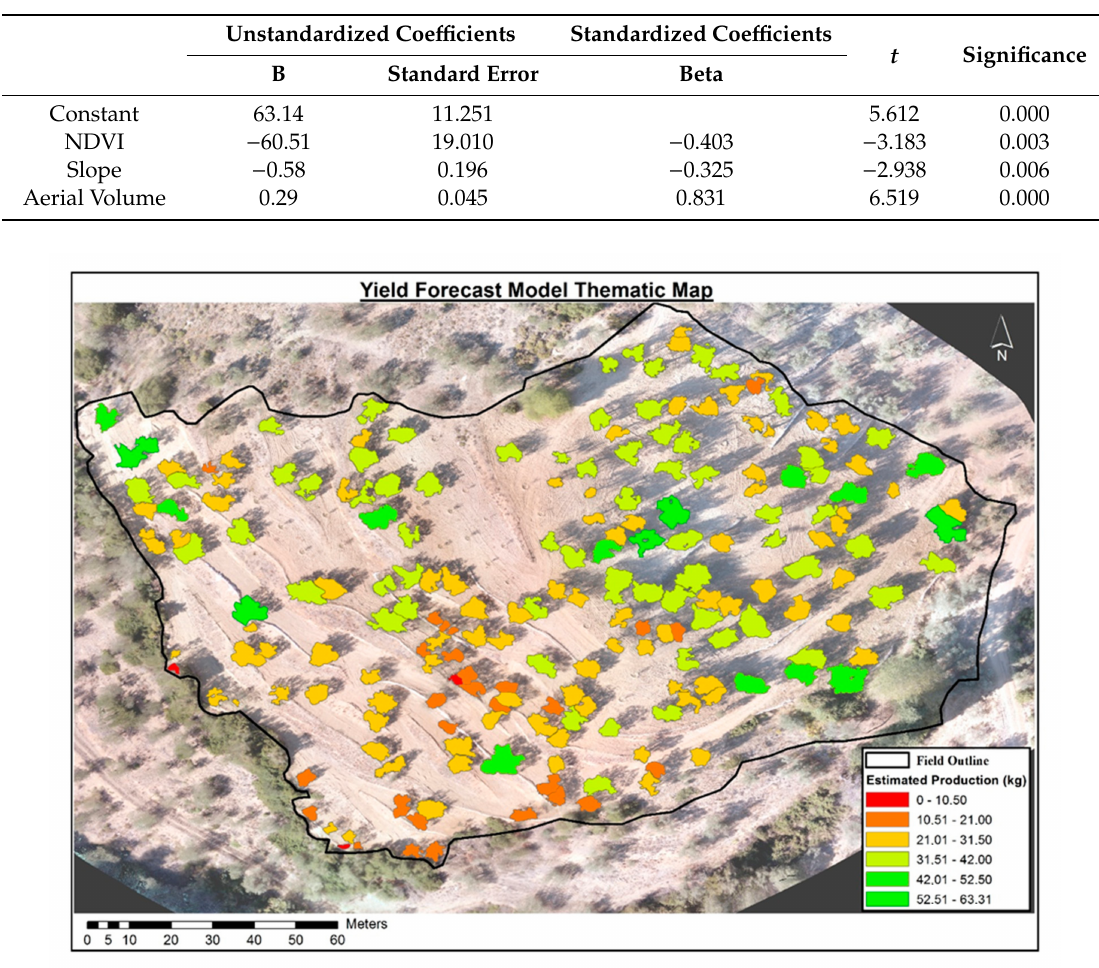
Figure 5. Thematic Map of Yield Forecast Model